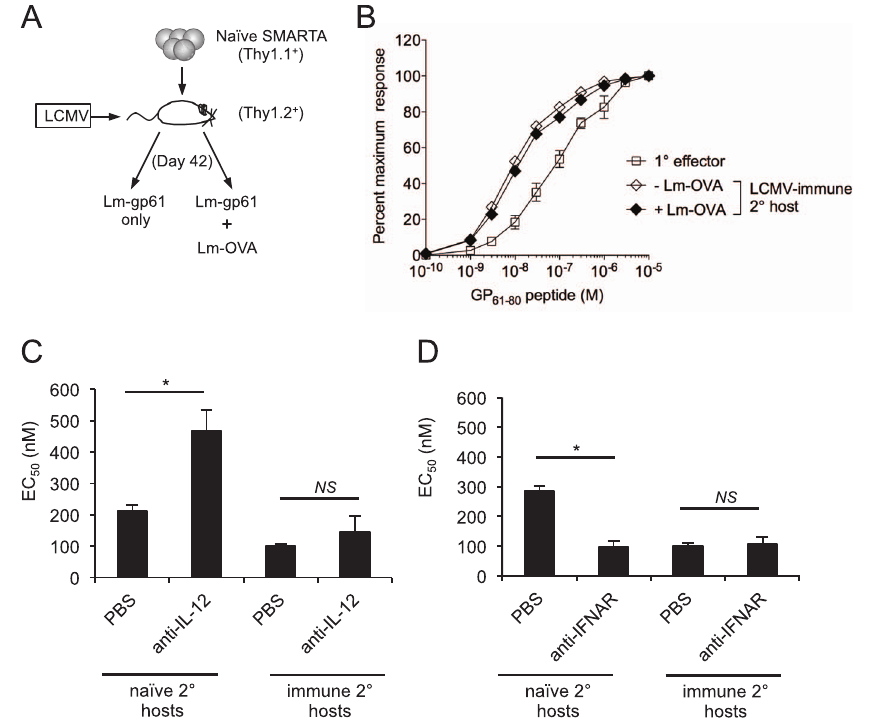
Figure 5. Functional avidity of secondary SMARTA Th1 cells is regulated by inflammatory environment. A ) Memory SMARTA cells (Thy1.1 + ) in LCMV-immune hosts (Thy1.2 + , . 42 days post-infection) were rechallenged with Lm-gp61 alone or co-challenged with Lm-gp61 and Lm- OVA. B ) Graph displays the functional avidity of secondary SMARTA effectors cells in the spleen at day 7 after Lm-gp61 rechallenge with or without Lm-Ova co-immunization, as compared to primary SMARTA Th1 effector cells in the spleen 8 days after LCMV infection. C ) Graph displays the EC 50 of secondary SMARTA Th1 cells in the spleen after rechallenge in naı¨ve or LCMV-immune secondary hosts. Indicated groups of mice were treated with anti-IL-12 neutralizing antibody or PBS prior to challenge. D ) Graph displays the EC 50 of secondary SMARTA effector cells in the spleen day 7 after rechallenge in naı¨ve or LCMV-immune secondary hosts. Indicated groups of mice were treated with anti-IFNAR1 antibody or PBS prior to challenge. Error bars indicate the SEM (n=4 mice/group). * p , .05; NS =not significant, as determined by student’s